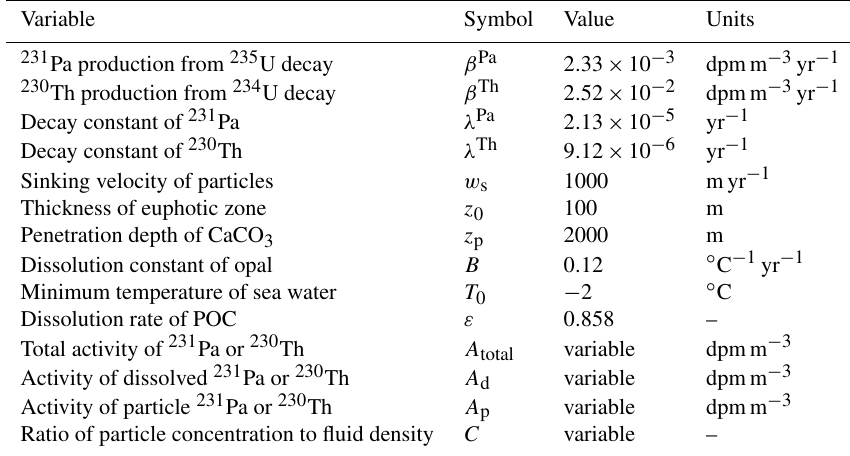
Table 1. Parameters of the 231 Pa and 230 Th model.